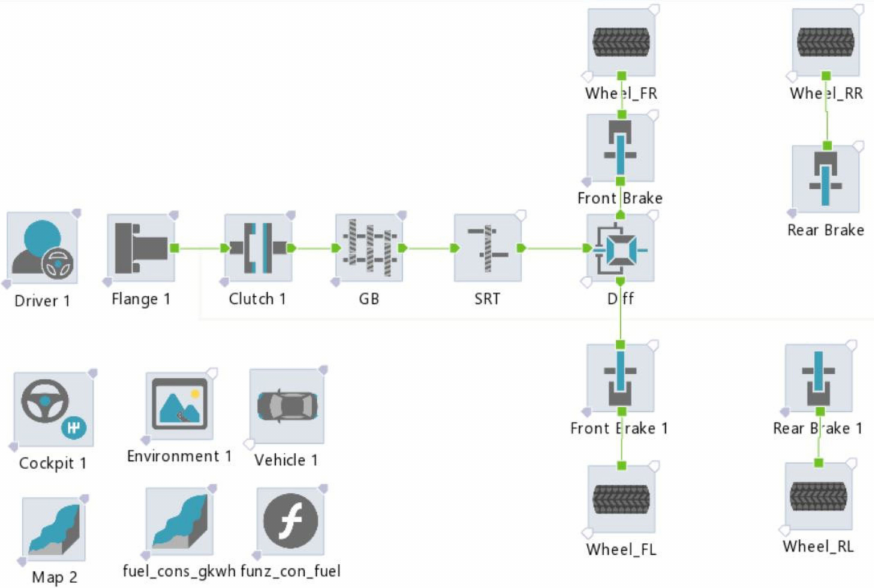
Figure 2. Vehicle’s plan model on the AVL Cruise-M™ workspace.